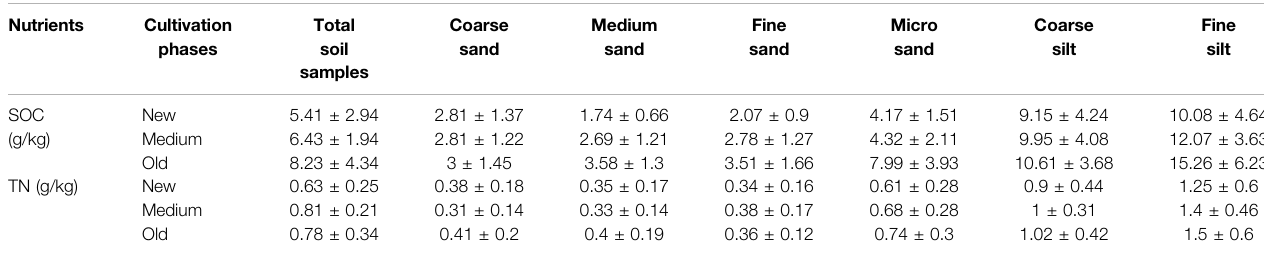
TABLE 3 | SOC and TN contents in the CLs with the different cultivation years. Nutrients Cultivation